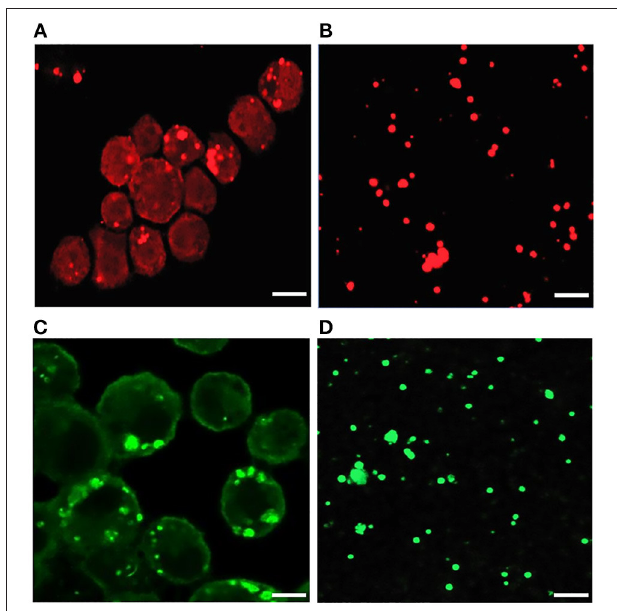
FIGURE 1 | Confocal microscopy images of infected E. chaffeensis in DH82 cells and purified cell-free Ehrlichia organisms. About 80–90% infected DH82 culture was used in the experiment where E. chaffeensis specific anti-p28 OMP monoclonal antibody (A) and DnaK polyclonal sera (B) was used. Similarly, cell-free purified bacteria were immunolabeled with p28-OMP monoclonal (C) and DnaK polyclonal sera (D) . (Scale bar, 10 µ